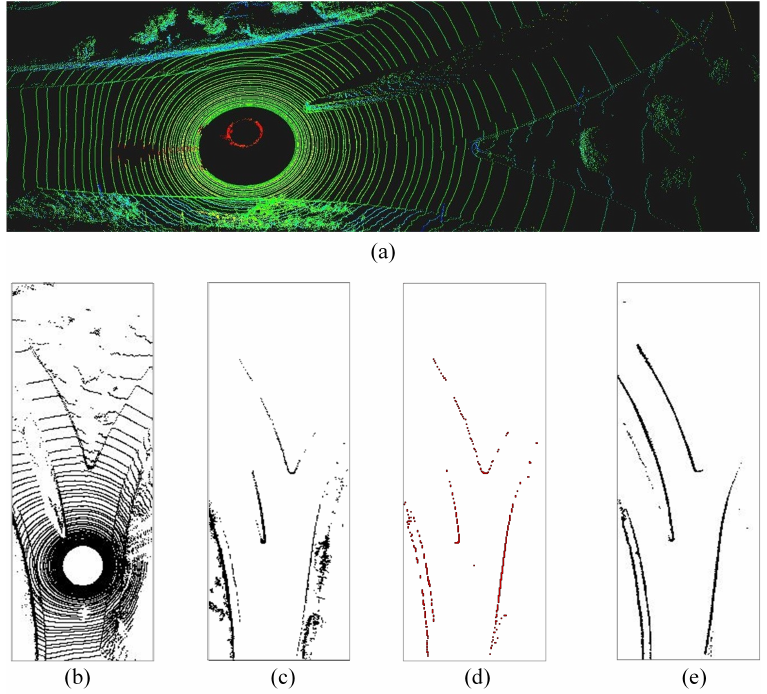
Figure 2. Road boundary extraction. ( a ) the 3D point cloud of a scene. ( b ) the 2D projection. ( c ) the ground elimination. ( d ) the road boundaries extracted in one frame. ( e ) the multiframe probabilistic